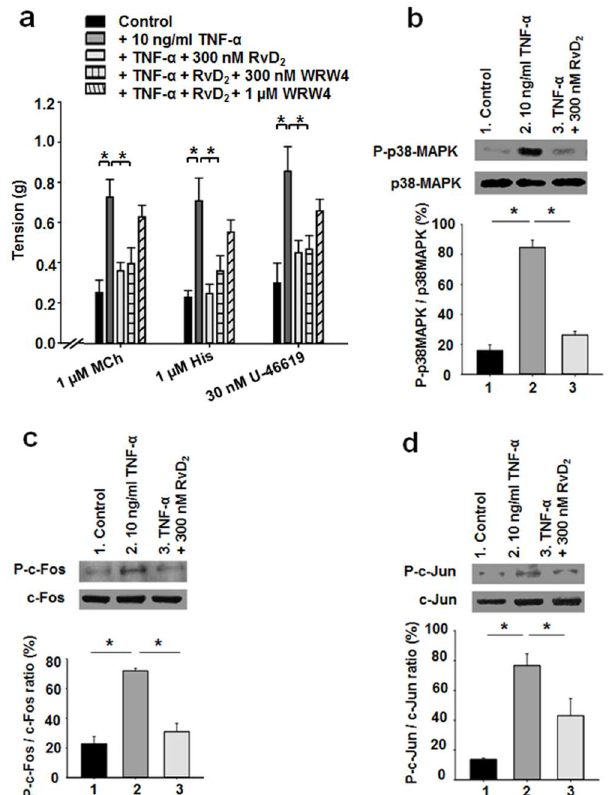
Fig 2. Effect of RvD 2 on TNF- α -induced reactivity and inflammation in human bronchi. a. Bar graph of the contractileactivity inducedby bronchoactive agents (MCh, His and U-46619) on 48-h cultured human bronchi in control (untreated, n = 7–12) conditions, 10 ng/ml TNF- α (n = 14–19), TNF- α + 300 nM RvD 2 (n = 15–26), TNF- α + RvD 2 + 300 nM WRW4 (n = 11–14)or TNF- α + RvD 2 + 1 μ M WRW4 (n = 10–11), * P < 0.05. b. Western blot analysesusing specific antibodiesagainst P-p38-MAPK and total p38-MAPK. Stainingdensitiesof P-p38-MAPK are expressedas a function of p38-MAPK levels (n = 5, * P < 0.05). c. Western blot analyseswere performed using antibodiesagainstp-c-Fos and total c-Fos. The relative density ratio of p-c-Fos to total c-Fos was used to quantify the comparative effects of RvD 2 on TNF- α -pretreated humanbronchi (n = 5, * P < 0.05). d. Western blot analyseswere performed using antibodiesagainst p-c-Jun and total c-Jun. Stainingdensitiesof p-c-Jun are expressedas a function of c-Jun levels (n = 5, * P <